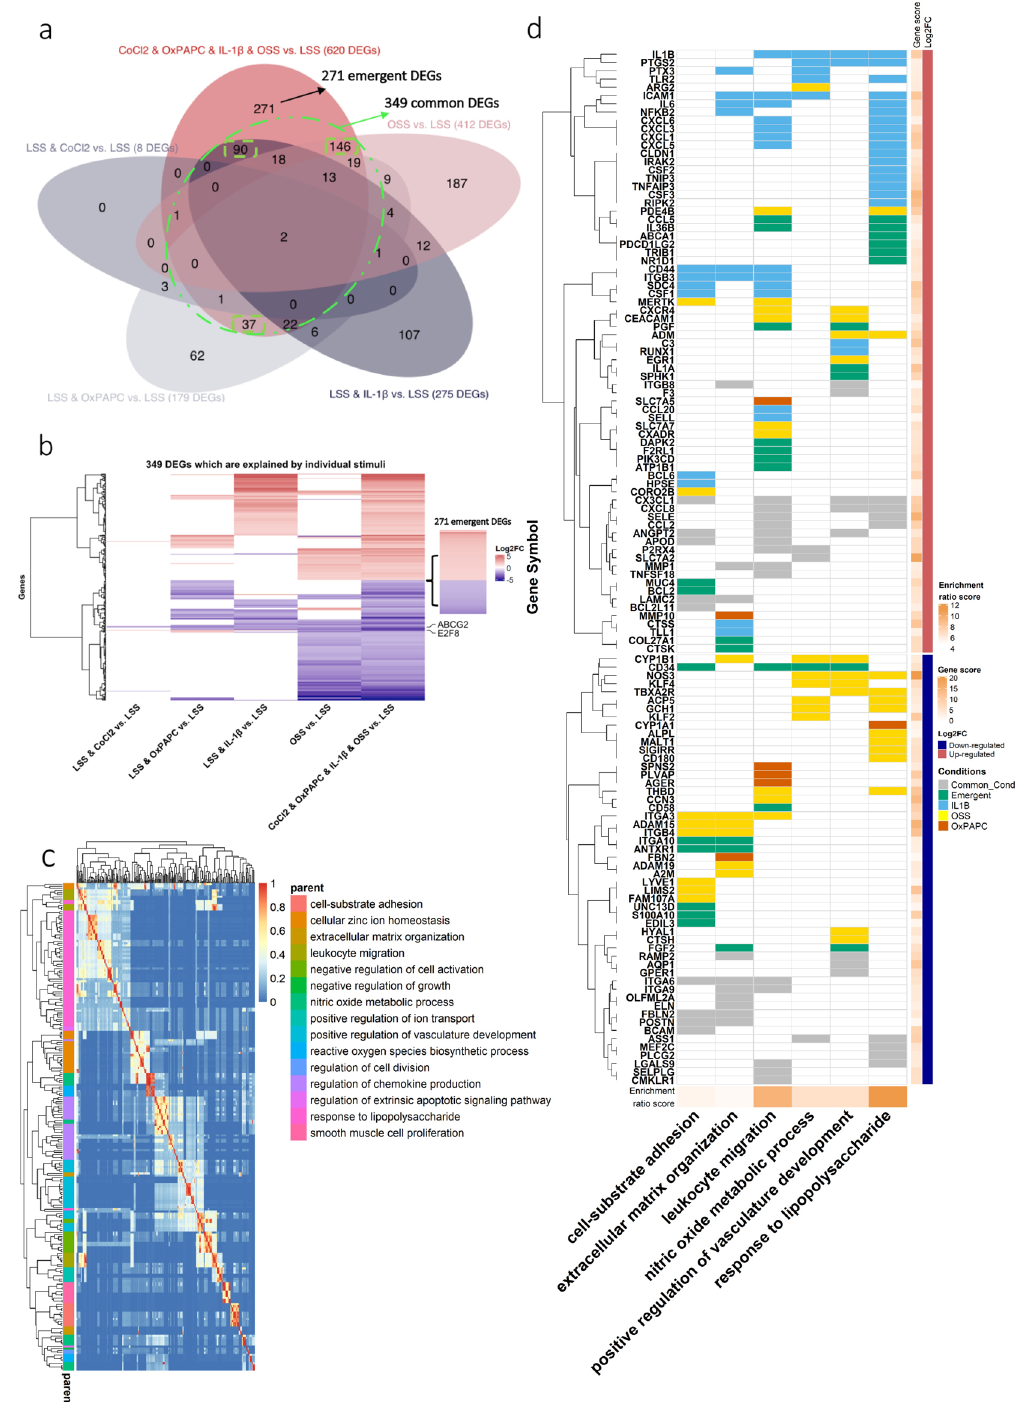
Figure 3. Dysregulated DEGs distribution on individual and clustered risk factors followed by GO map of biological process enriched for the 620 DEGs of the clustered risk factors vs. LSS. ( a ) Venn diagram of DEGs from each condition. The DEGs were considered as adjusted p -value ≤ 0.05 and |Log2foldchange|≥ 1.3; black circle and black arrow regard the unique DEGs from the clustered risk condition; dashed green circle and green arrow regard to the commonly shared genes of the clustered risk factors with each stimulus; dashed black line for unique stimuli- dependent genes, 146 DEGs for OSS, 90 for IL-1β and 37 for OxPAPC. ( b ) Heatmap of 349 DEGs shared among the DEGs from each stimulus. ( c ) Heatmap of the similarity matrix of enriched GO terms (biological process) for the clustered risk factors DEGs. Redundancy analysis was applied to identify and keep the most representative term from the redundant terms (cutoff = 0.7 and adjusted p -value ≤ 0.05). ( d ) Canonical enriched terms in CoCl 2 & IL-1β & OxPAPC & OSS vs. LSS (121 DEGs) and the source of the stimulus individual (represented by colours light blue, yellow and orange), common (grey), more than one stimulus, and if it is emergent, meaning that the gene is only altered if all four stimuli are combined (green). Gene score and enrichment risk score were calculated by − log 10 (adjusted p-